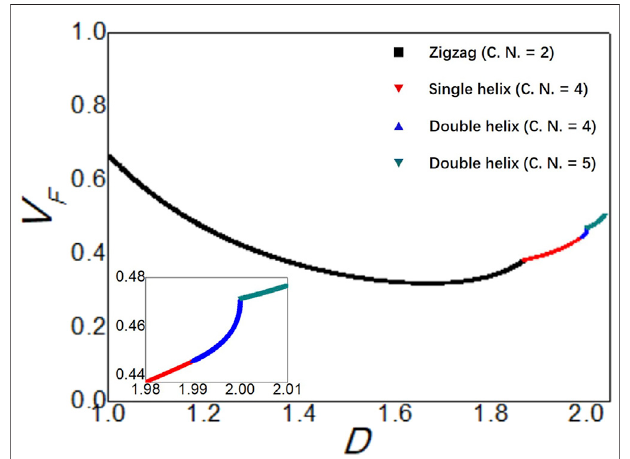
FIGURE 6 | Plot of the volume fraction V F of spheres as a function of the cylinder-to-sphere diameter ratio D . The inset indicates that this volume fraction is continuous across each structural transition.